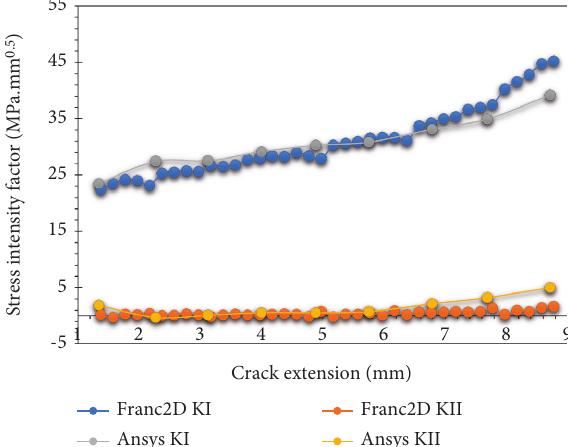
Figure 14: Stress intensity factors with corresponding crack length for CT02